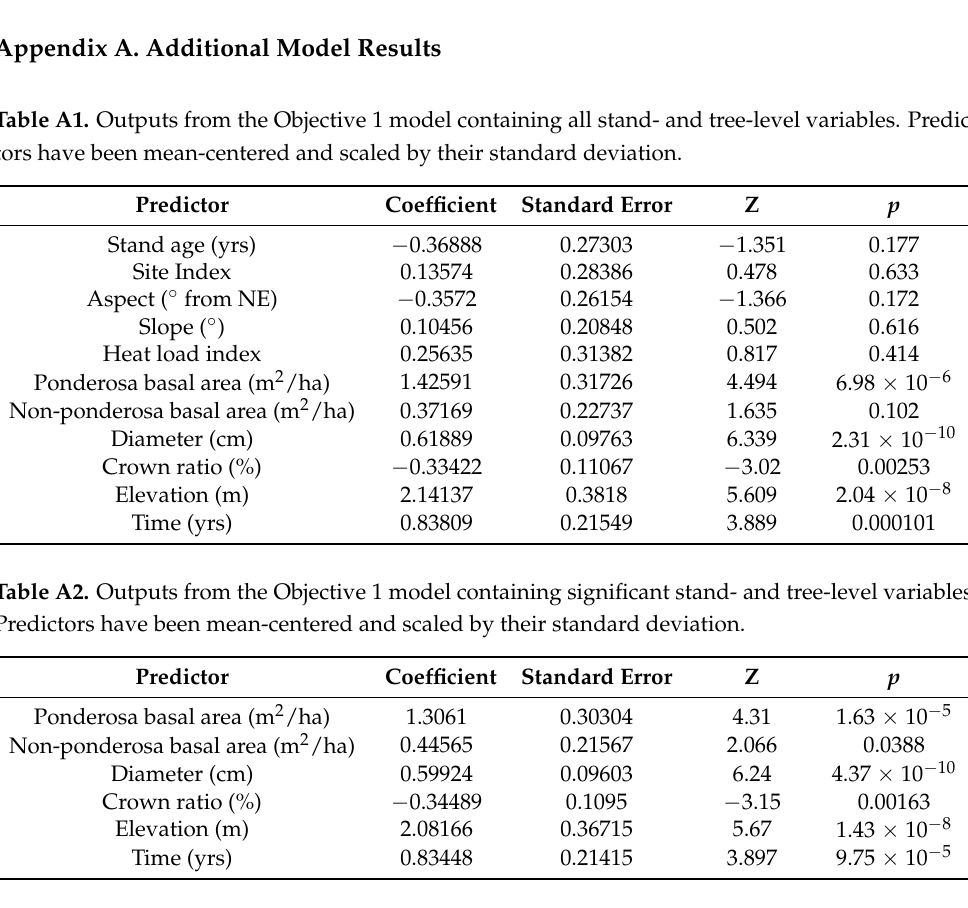
Table A3. Outputs from the Objective 2 model examining correlations between site climate and mortality risk. Predictors have been mean-centered and scaled by their standard